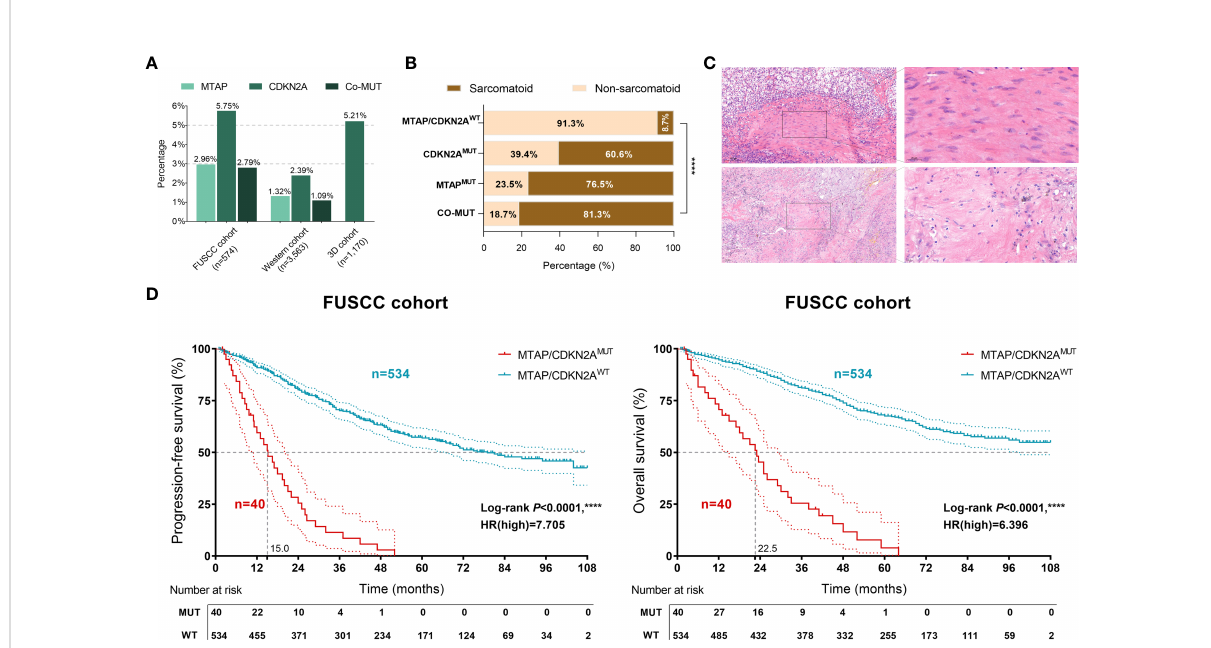
FIGURE 1 Clinical value of MTAP / CDKN2A MUT in sarcomatoid and the prognosis of 574 patients with renal cell carcinoma (RCC) from the discovery set of the Fudan University Shanghai Cancer Center (FUSCC) cohort. (A) Genomic alteration frequency of MTAP and CDKN2A in 574 Chinese patients with RCC from the FUSCC cohort; 3,563 RCC samples from 17 independent cohorts were integrated (Western cohort), and 1,170 Chinese patients with RCC were included from the 3D medicine cohort with panel sequencing data. (B) The proportion of sarcomatoid pathological features in 574 patients with RCC from the FUSCC cohort in different mutation groups. (C) The representative images of sarcomatoid pathological features in MTAP / CDKN2A MUT samples. (D) Classi fi ed by the MTAP / CDKN2A MUT , progression-free survival (PFS) and overall survival (OS) of 574 RCC patients from the FUSCC cohort using Kaplan – Meier curve analysis. ****,